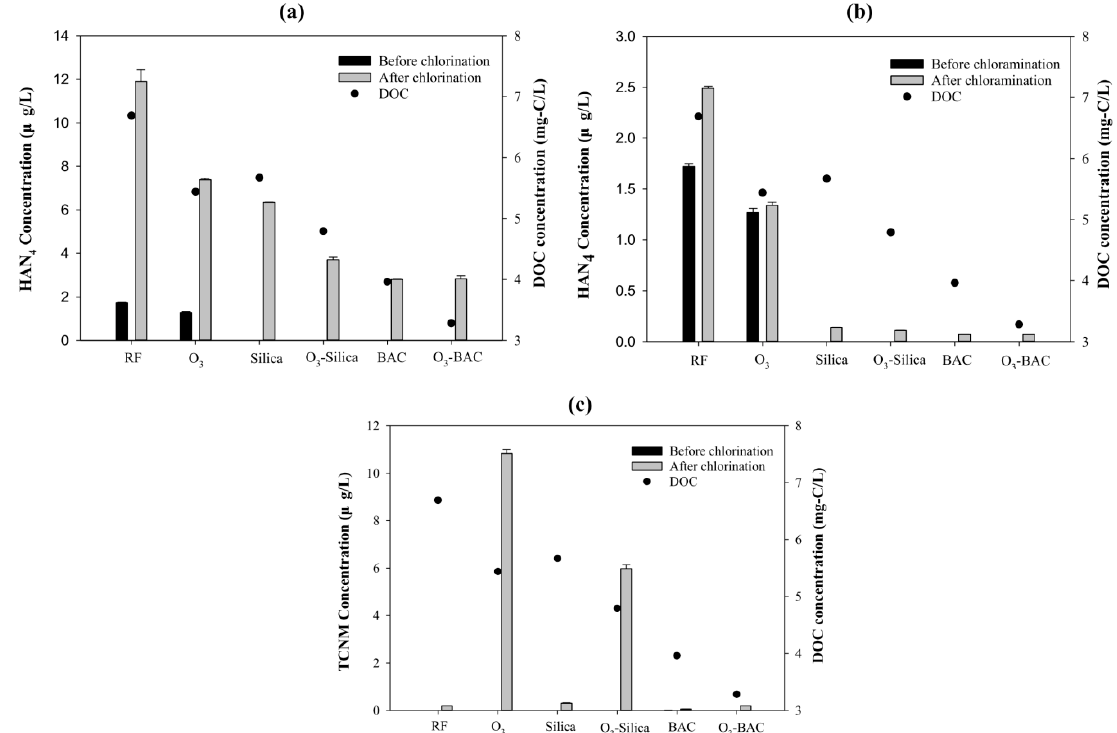
Figure 3. Simulated distribution system (SDS) tests: nitrogenous disinfection byproducts (DBPs). The DBPs measured were HAN 4 , with chlorine ( a ) or chloramine ( b ) as the disinfectant, and TCNM with chlorine as the disinfectant ( c ). Effluent from rapid sand filtration (RF) was treated by ozonation and/or biofiltration processes. Solid black and gray bars represent the concentrations of disinfection byproducts before and 24 h after adding indicated the disinfectants, respectively. Solid circles indicate DOC concentrations. (O 3 : ozonation; Silica: silica sand biofiltration; BAC: biological activated-carbon biofiltration).